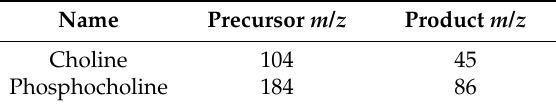
Table 2. Precursor-product ion